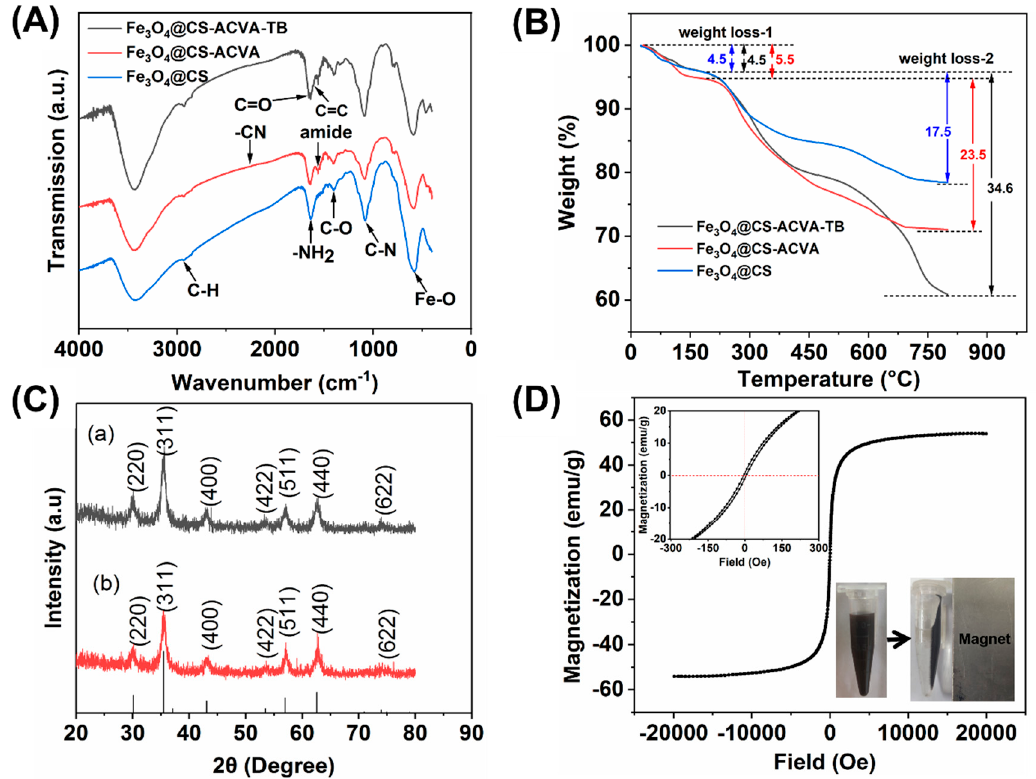
Figure 1. ( A ) Infrared spectroscopy and ( B ) thermogravimetric analysis of Fe 3 O 4 @CS-ACVA-TB, Fe 3 O 4 @CS-ACVA, and Fe 3 O 4 @CS, respectively. ( C ) XRD pattern of (a) Fe 3 O 4 @CS and (b) Fe 3 O 4 @CS-